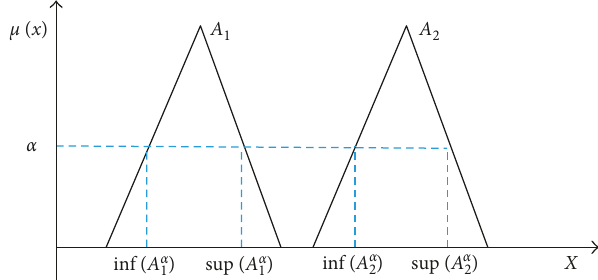
Figure 1: α -cut of membership function: infimum and supremum.